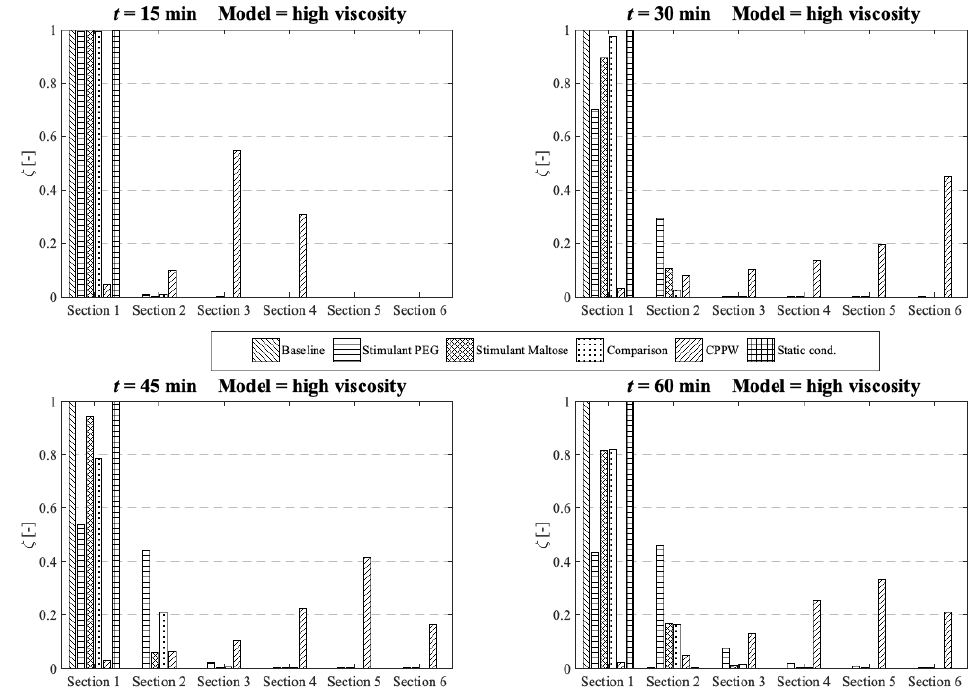
Figure 12. Comparison of the different models in respect to the distribution of the API along the colon at four different times at high fluid viscosity conditions.